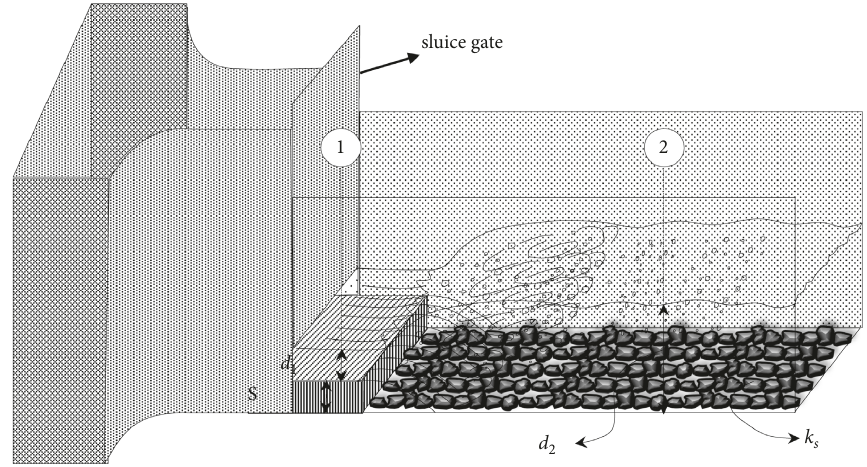
Figure 2: Definition sketch for the free